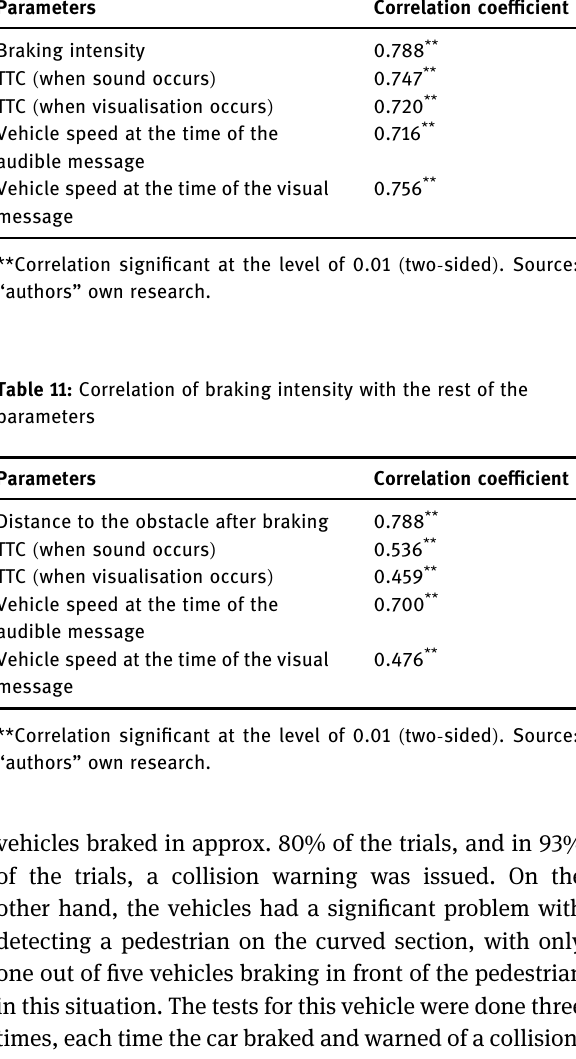
Table 10: Correlation of distance to the obstacle after braking with the rest of the parameters Parameters Correlation coe ffi cient Braking intensity